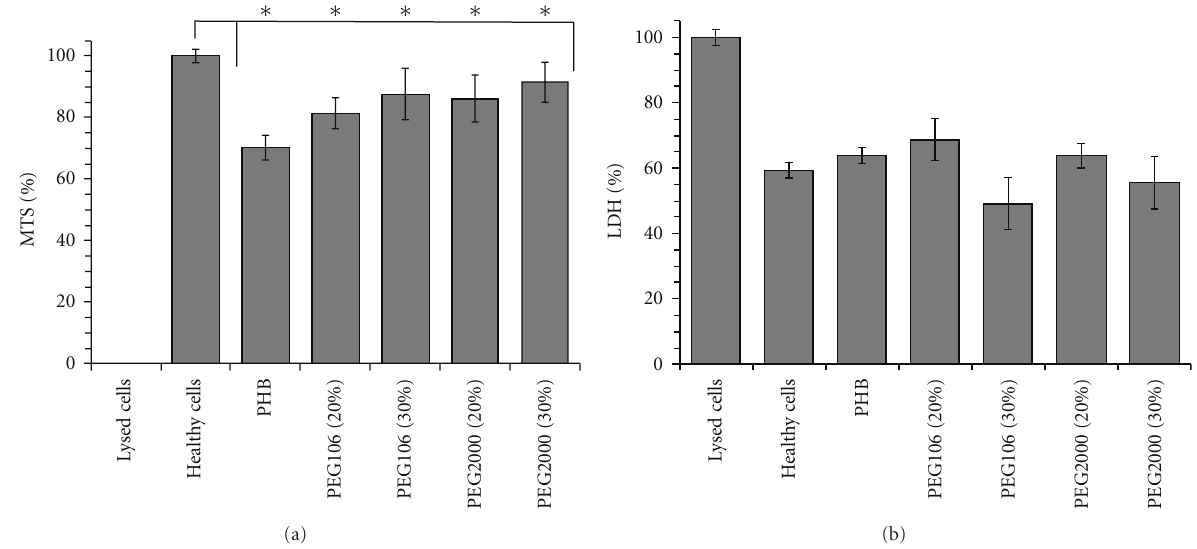
Figure 10: Changes in cellular activity relative to healthy cells, for olfactory ensheathing cells cultivated on PHB and PHB/PEG composite films: (a) MTS concentrations and (b) LDH release ( ∗ P > 0 . 005 significance, n =